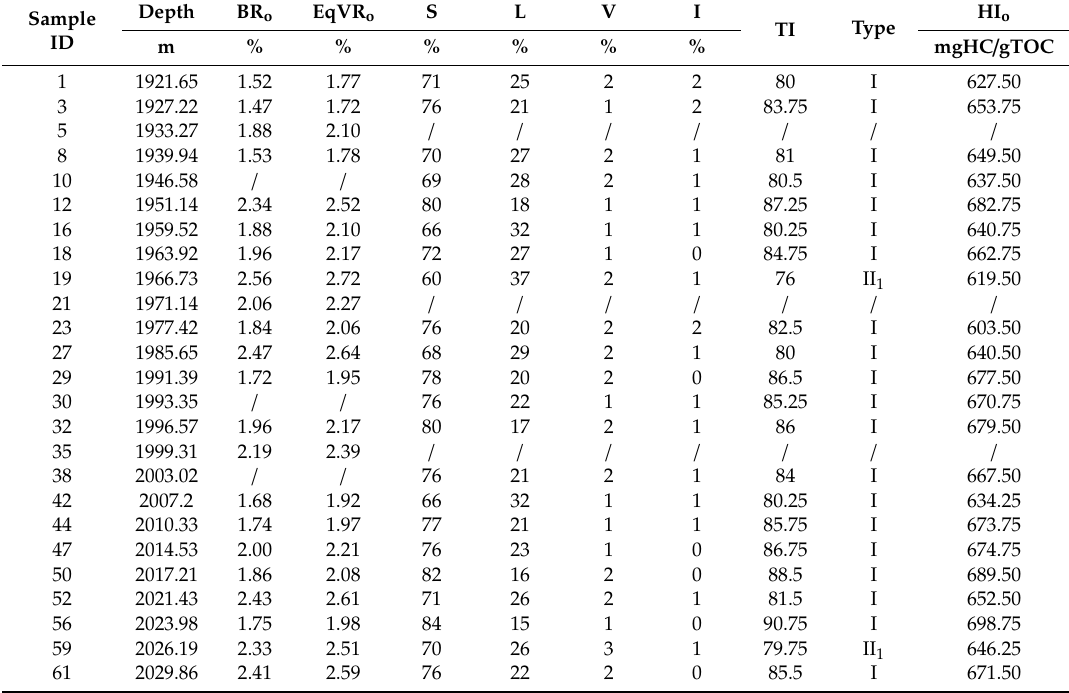
Table 2. Sample thermal maturity and